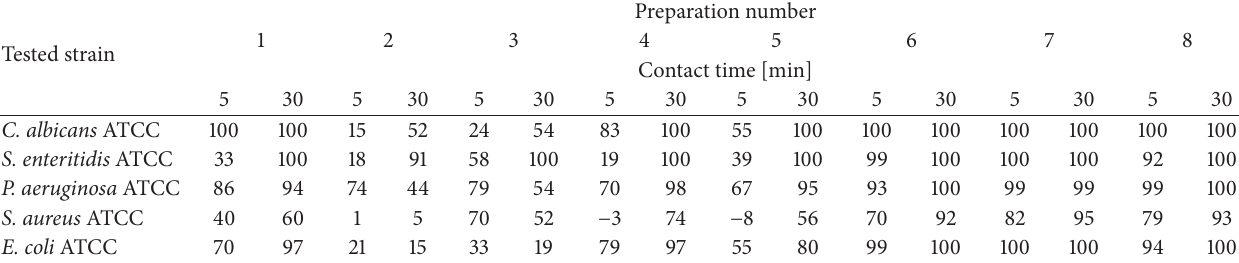
Table 3: Percentage reduction in the amount of microorganisms compared to the control sample for the tested nanosilver preparations.